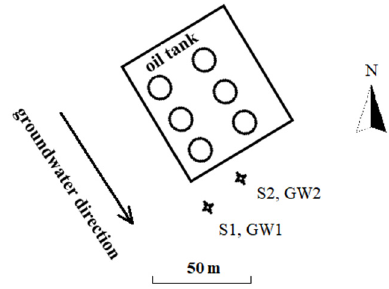
Figure 1. Locations of the soil and groundwater sampling points (S indicates soil, and GW indicates groundwater).